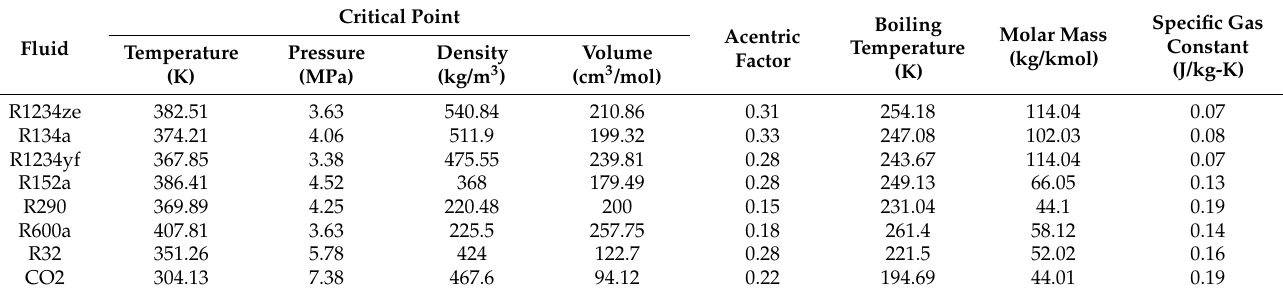
Table 2. Fluid Properties.